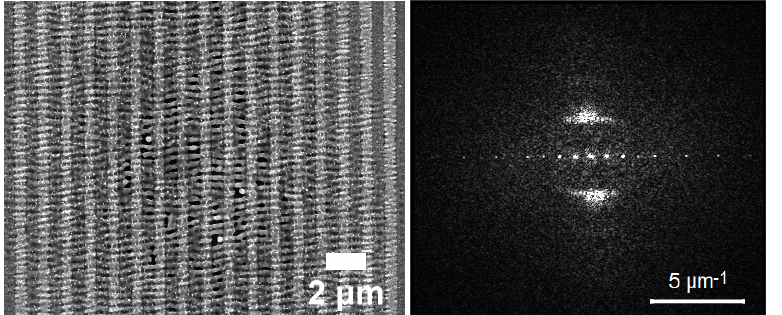
Figure 2. Pattern ( left ) with LIPSS periodicity measured through 2D-Fast Fourier Transform ( right ) on the SEM micrograph.